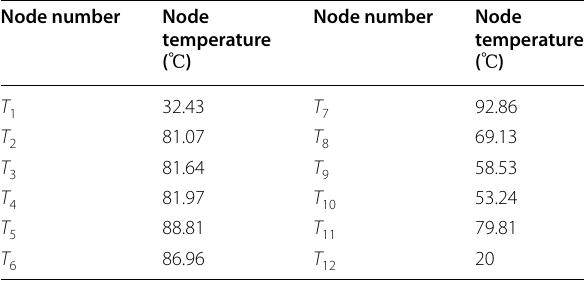
Table 2 Isothermal nodes